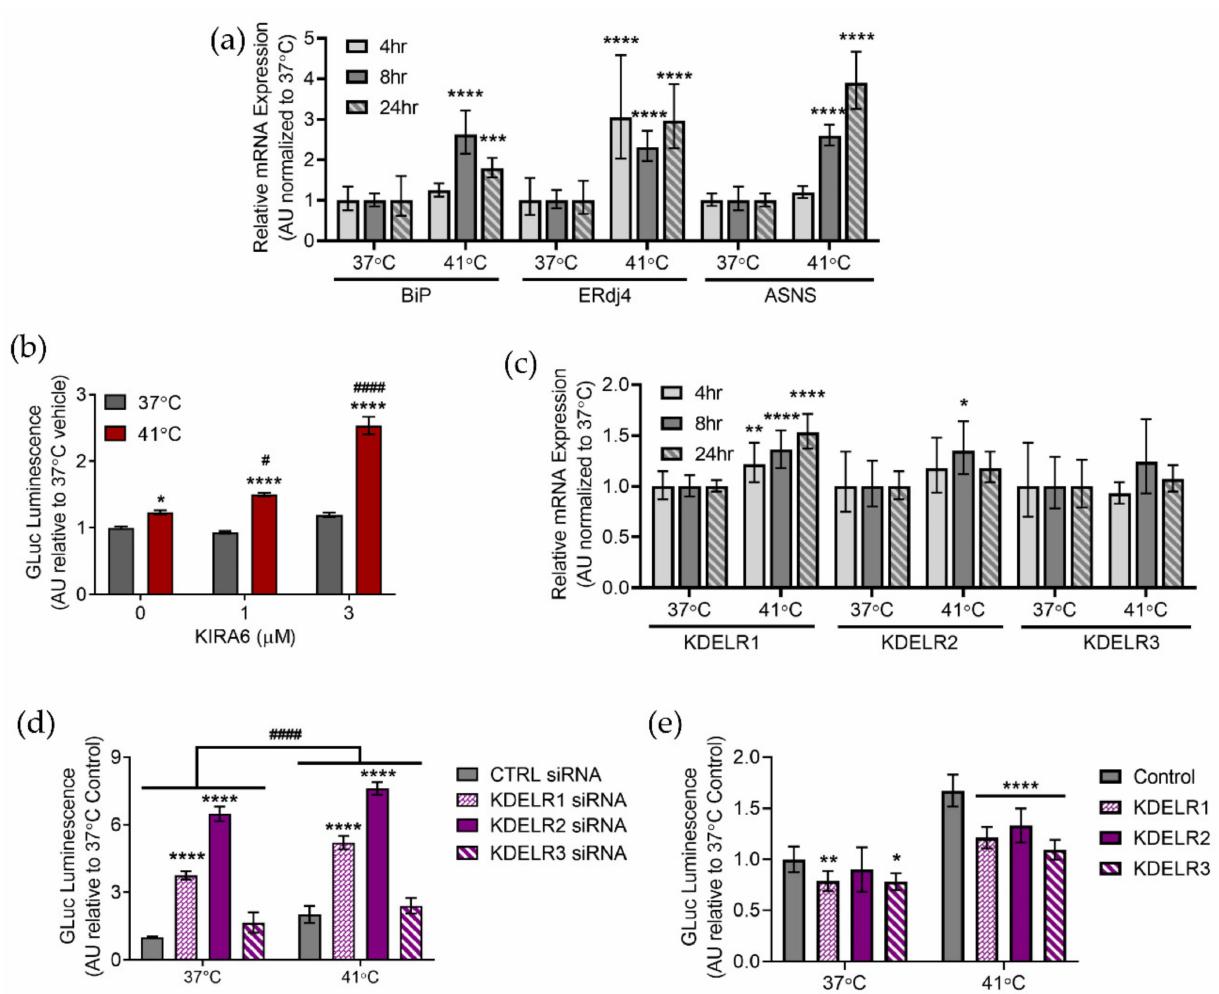
Figure 3. The UPR and KDEL receptors in hyperthermic conditions. ( a ) BiP , ERdj4 , and ASNS mRNA levels analyzed with real-time RT-qPCR after a 4, 8, or 24 h exposure to 37 ◦ C or 41 ◦ C. Data are shown as relative mRNA expression (arbitrary units: AU) relative to control (2 − ddCq ± upper and lower limits, n = 8, two-way ANOVA with Sidak’s multiple comparisons, *** p < 0.001 and **** p < 0.0001 37 ◦ C vs. 41 ◦ C). ( b ) GLuc (arbitrary units: AU) in the media from SH-SY5Y cells stably expressing GLuc-ASARTDL after a 1 h treatment with vehicle or KIRA6 (1 µ M or 3 µ M) followed by a 24 h incubation at 37 ◦ C or 41 ◦ C (mean ± SEM, n = 48, two-way ANOVA with Tukey’s multiple comparisons, * p < 0.05 and **** p < 0.0001 37 ◦ C vs. 41 ◦ C, # p < 0.01 and #### p < 0.0001 vehicle vs. KIRA6). ( c ) KDELR1 , KDELR2 , and KDELR3 mRNA levels analyzed with real-time RT-qPCR after a 4, 8, or 24 h exposure to 37 ◦ C or 41 ◦ C. Data are shown as relative mRNA expression (arbitrary units: AU) relative to control (2 − ddCq ± upper and lower limits, n = 8, two-way ANOVA with Sidak’s multiple comparisons, * p < 0.05, ** p < 0.01, and **** p < 0.0001 37 ◦ C vs. 41 ◦ C). ( d ) GLuc (arbitrary units: AU) in media following transfection of SH-SY5Y cells stably expressing GLuc-ASARTDL with 10 nM KDEL receptor siRNA (mean ± SEM, n = 12, two-way ANOVA with Dunnett’s multiple comparisons, #### p < 0.0001 37 ◦ C vs. 41 ◦ C, **** p < 0.0001 control vs. KDELR siRNA). ( e ) GLuc (arbitrary units: AU) in media following transduction of SH-SY5Y cells stably expressing GLuc- ASARTDL with lentiviral KDEL receptors and a 24 h exposure to 37 ◦ C or 41 ◦ C (mean ± SEM, n = 12, two-way ANOVA with Dunnett’s multiple comparisons, p < 0.0001 37 ◦ C vs. 41 ◦ C, * p < 0.05, ** p < 0.01, and **** p < 0.0001 control vs.